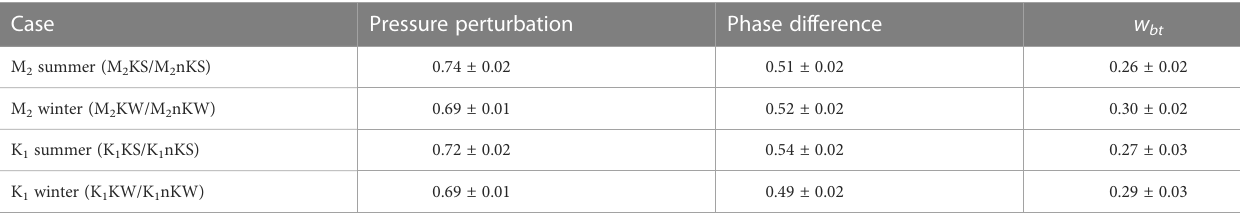
TABLE 4 Pearson correlation coef fi cients between the conversion rate ratio and the three factors listed in the column headings. Case